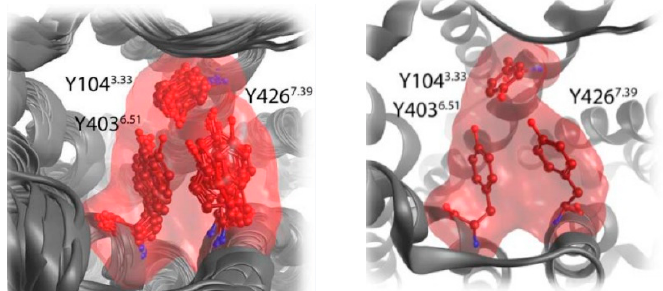
Figure 15. Left: top view snapshots from a molecular dynamics simulation of the iperoxo-bound crystal structure unveil the conformational flexibility of the tyrosine lid, especially Tyr-426 7.39 . Right: based on the sampling of side chain conformations, the tyrosine lid was remodeled for binding mode investigations on dualsteric agonist. Reproduced with permission from [83].